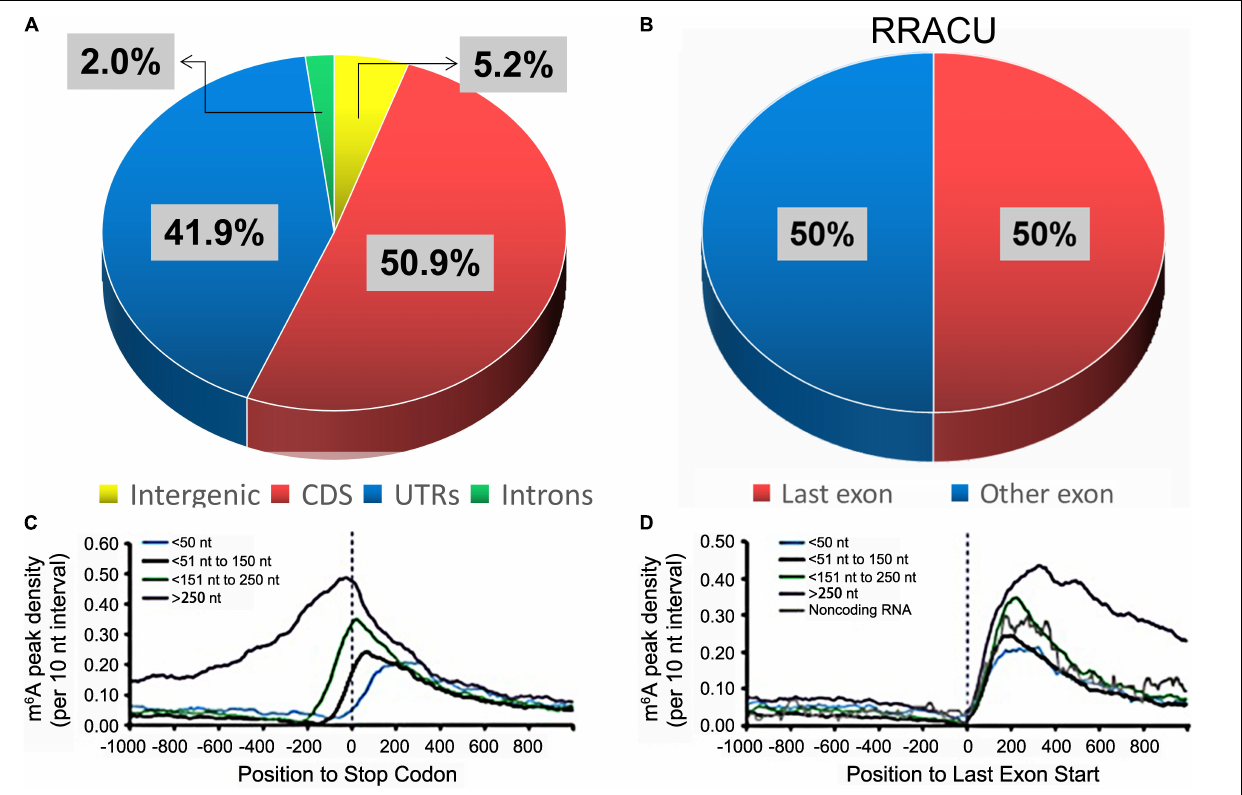
FIGURE 4 | The distributions of m 6 A peaks. (A) The percentage of m 6 A peaks within distinct RNA sequence types. (B) The relative proportions of RRACU motifs in the last exon and other exons, with 100% representing all RRACU sequences in mRNA (Ke et al., 2015). (C,D) In the last exon, m 6 A density increased sharply (Ke et al., 2015). mRNAs were grouped according to their stop codon locations relative to the start of the last exon (D)